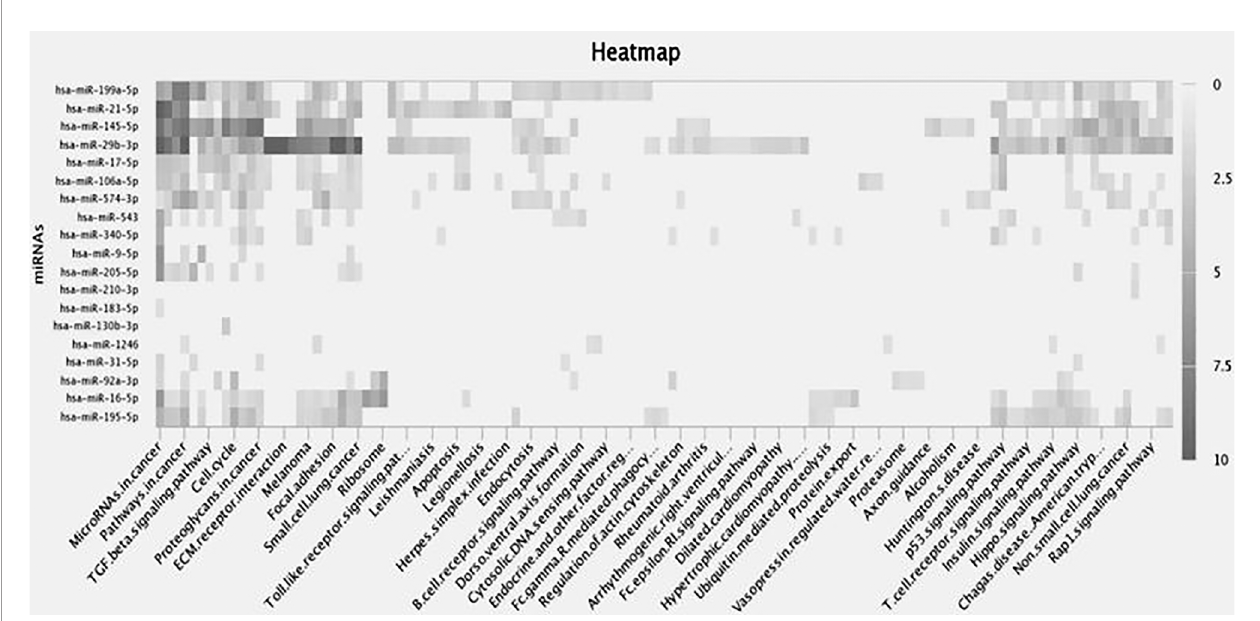
FIGURE 3 | Heat map depicts differential expression of miRNAs in various biological processes. Rows represent enrichment results for the target miRNAs whereas columns show biochemical pathways. Each highlighted miRNA is correlated to the adjacent biological process in the black color gradient. The color of individual fi elds represents P-value of the enrichment results. The dark shade shows a strong correlation between miRNA and the target pathways, the light shades correspond to weaker ones, whereas transparent area explains no role of miRNA in that